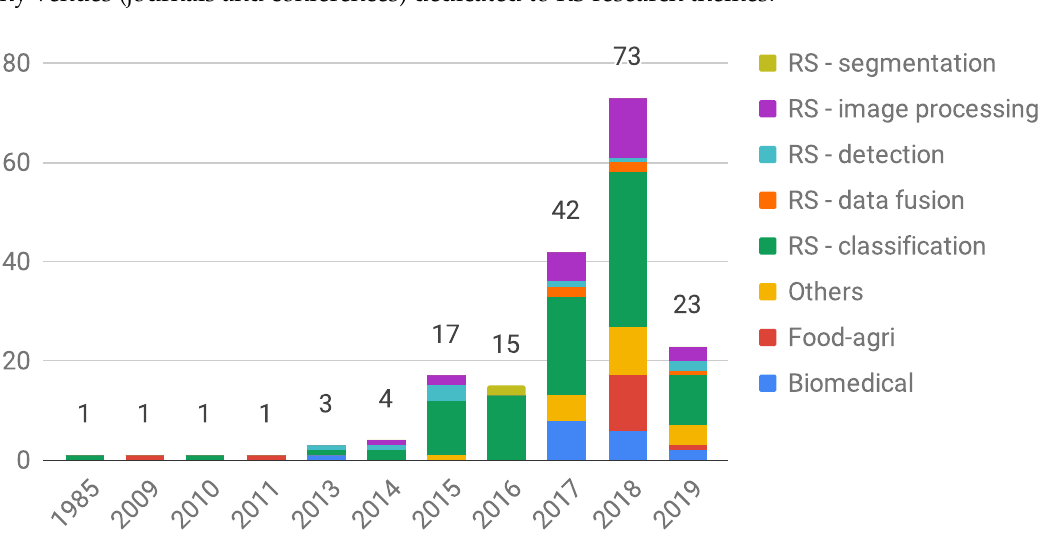
Figure 3. Number of HSI-DL articles per year. The last column comprises published and in-press papers found up to 31 January